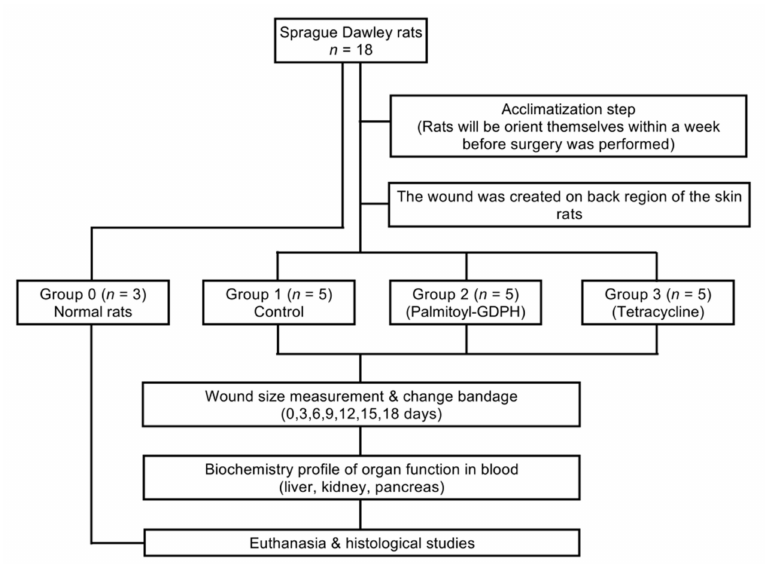
Figure 1. Flow diagram showing how the animals were used in this